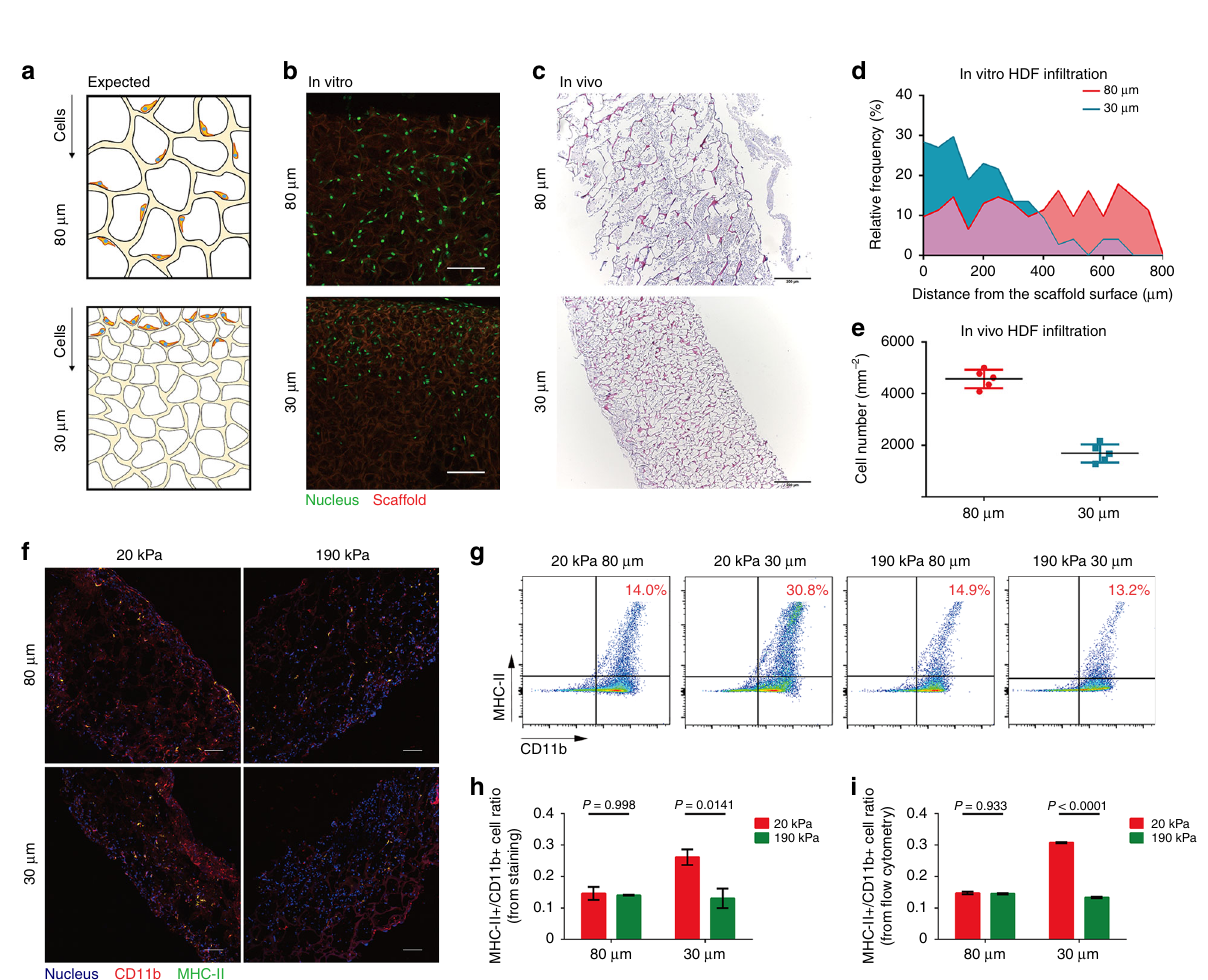
Fig. 5 Physical con fi nement contributes to pore-regulated cellular mechano-responsiveness. a , b Confocal images of HDFs and BMDMs cultured on 2D substrates and subjected to physical con fi nement induced by osmotic pressure (tuned by PEG concentration). c , d Characterization of 2D-cultured HDF elongation ( n = 16) and α SMA expression ( n = 20) upon being subjected to different osmotic pressures. e , f Characterization of 2D-cultured BMDM elongation ( n = 10) and MHC-II expression ( n = 3) upon being subjected to different osmotic pressures. g , i , j Characterization of osmotic pressure- induced HDF elongation ( n ≥ 7) and α SMA expression ( n ≥ 11) in 3D scaffolds with a large pore size and differing stiffness. h , k , l Characterization of osmotic pressure-induced BMDM elongation ( n = 16) and MHC-II expression ( n ≥ 8) in 3D scaffolds with a large pore size and differing stiffness. Scale bar: 50 μ m. Data are means± s.d. (ANOVA)